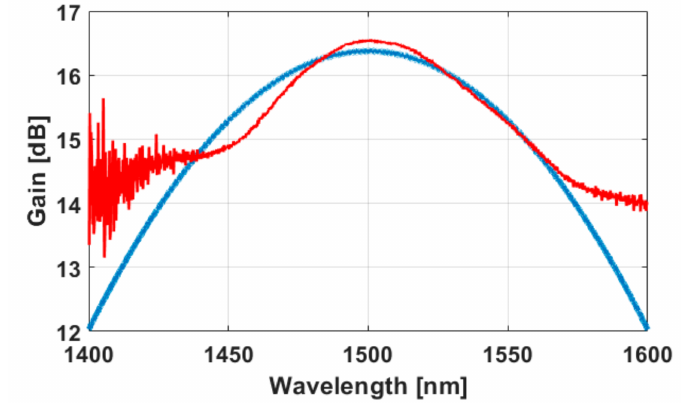
Figure 3. Simulated (blue) and experimental (red) SOA gain